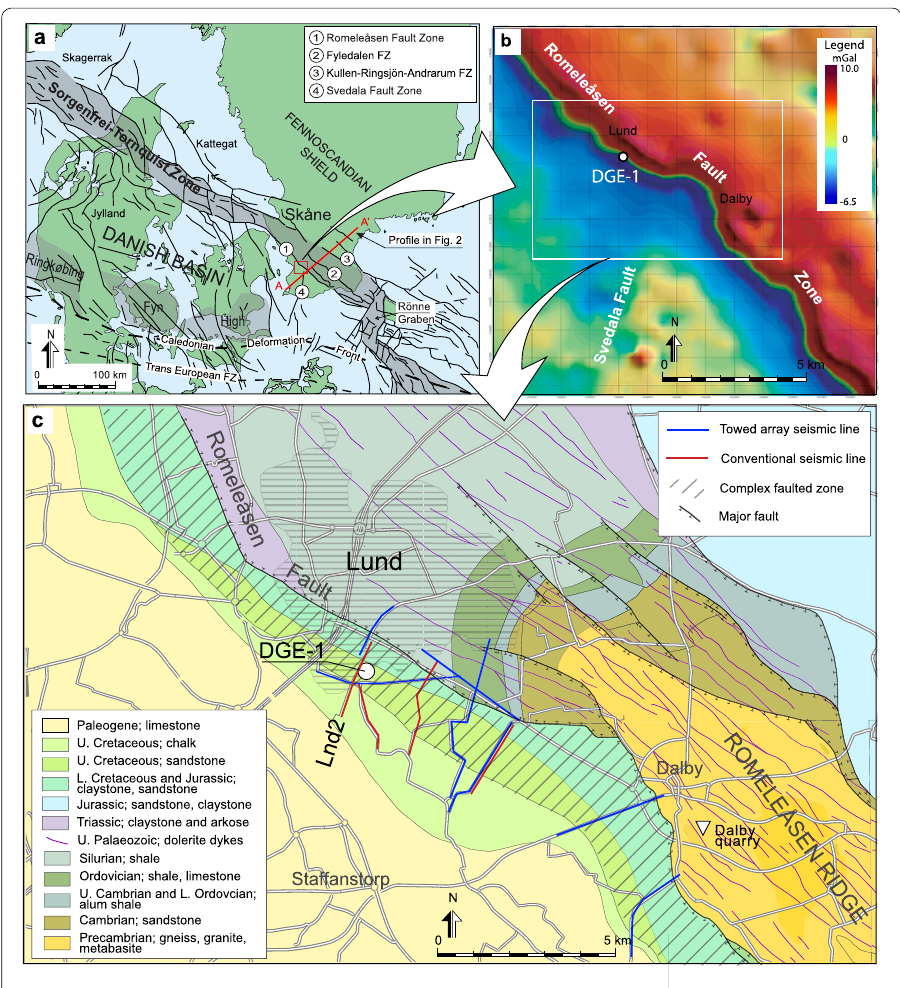
Fig. 1 a Map showing the regional structural framework of the SW Fennoscandian Shield and the Danish Basin, and location of the prospect area (red frame) and profile A–A ′ shown in Fig. 2. b Bouguer anomaly map showing the gravimetric signature of the Romeleåsen Fault Zone between Lund and Dalby as well as the location of the DGE‑1 site, c bedrock map of the DGE‑1 site area (framed area in b ) and location of the seismic survey lines. Line Lnd2 is presented in Fig. 4